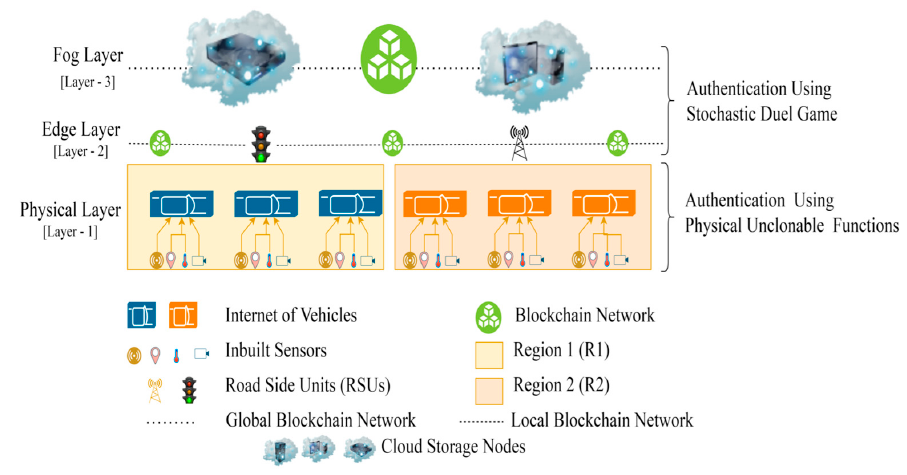
Figure 4. Layer wise Authentication Mechanisms. Sensors 2022 , 22 , x FOR PEER REVIEW